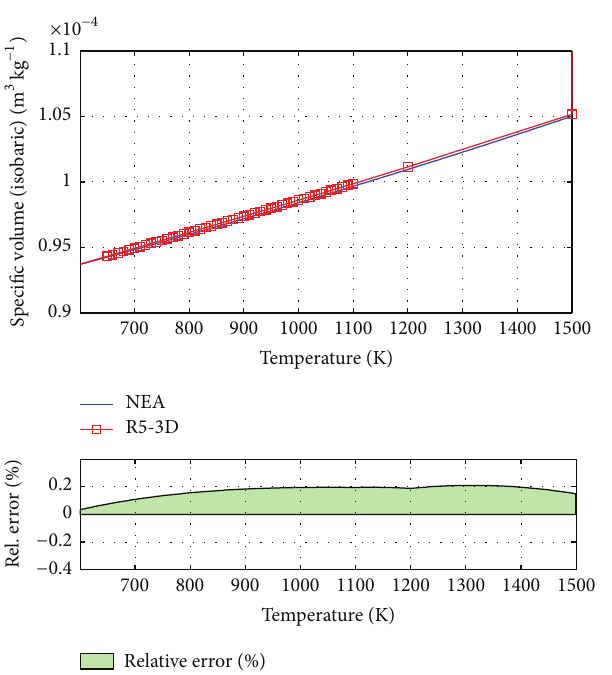
Figure 10: Lead liquid isothermal compressibility, original R5-3D “tpf” file versus NEA report.